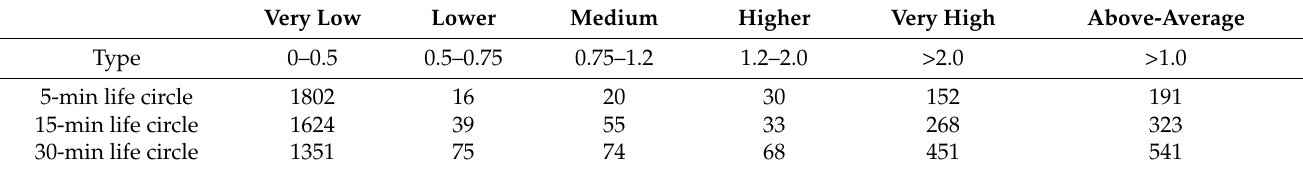
Table 6. Classification statistics of residential location entropy under different traveling